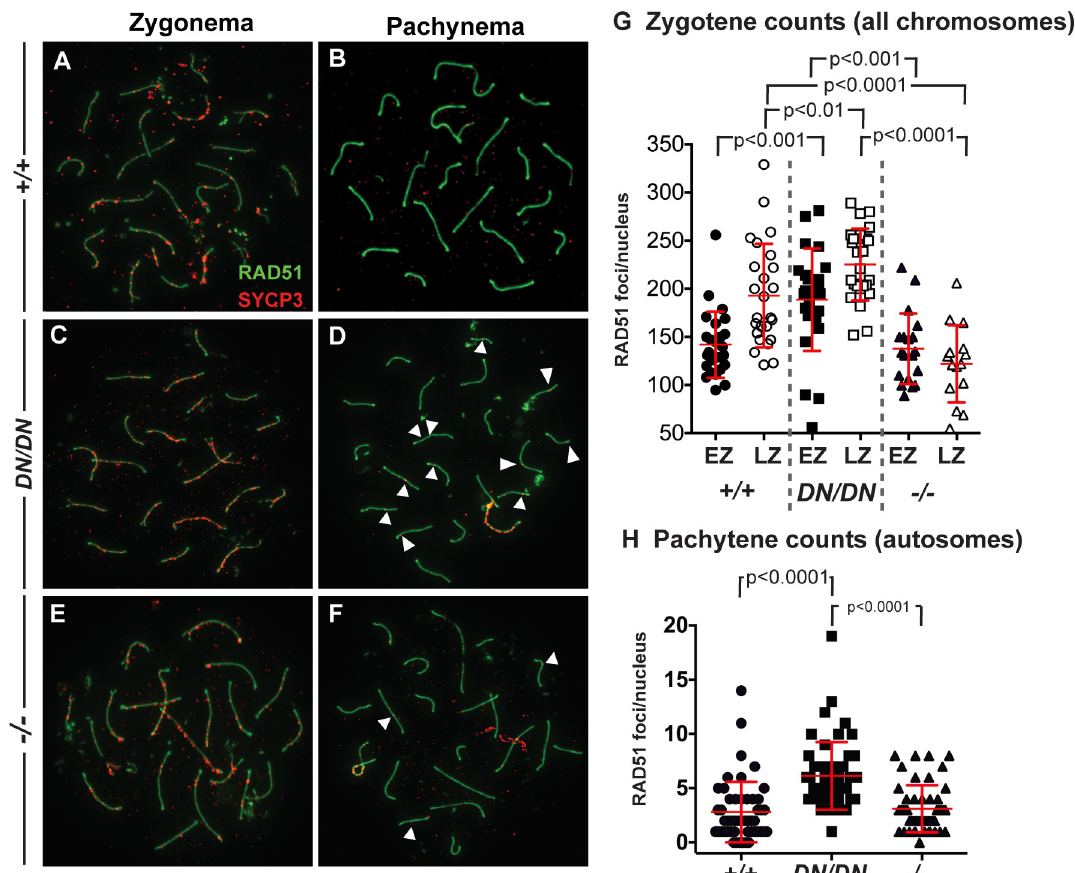
Fig 2. Mlh3 DN/DN spermatocytes show a persistence of RAD51 foci in pachynema. The localization of RAD51 (green) on synaptonemal complex protein SYCP3 (red) is observed in (A, B) WT and (C, D) Mlh3 DN/DN male spermatocytes in zygonema and pachynema. (A, C, E, G) In early zygonema, WT cells show high numbers of RAD51 associated with the chromosome cores while Mlh3 DN/DN exhibit even higher RAD51 foci (WT mean ± standard deviation = 142.1 ± 34.5 foci, Mlh3 DN/DN mean ± s.d. = 188.8 ± 53.3 foci; p values indicated on graph, by unpaired t-test with Welch’s correction, and using Bonferroni’s adjustment for multiple comparison). In late zygonema, Mlh3 DN/DN spermatocytes continue to have higher RAD51 foci than WT (WT mean ± s.d. = 193.0 ± 53.7 foci, Mlh3 DN/DN mean ± s.d. = 225.3 ± 37.3 foci; p values indicated on graph, by unpaired t-test with Welch’s correction, and using Bonferroni’s adjustment for multiple comparison). Mlh3 -/- late zygotene cells show significantly fewer RAD51 focus counts (mean = 122.1 ± 39.9 foci) when compared to WT and Mlh3 DN/DN (p values indicated on graph, by unpaired t-test with Welch’s correction, and using Bonferroni’s adjustment for multiple comparison). In all cases, at least 3 mice were assessed for each genotype and at least 20 cells per mouse (B, D, F, H). In pachynema, WT cells exhibit a dramatic decrease of very few to no RAD51 associated with the autosomes while Mlh3 DN/DN cells show persistent RAD51 (WT mean ± s.d. = 2.8 ± 2.8 foci, Mlh3 DN/DN mean ± s.d. = 6.1 ± 3.1 foci; p < 0.0001, unpaired t-test). Mlh3 -/- pachytene cells exhibit comparable RAD51 focus counts (mean ± s.d. = 3.1 ± 2.1 foci) when compared to WT (p = 0.55 by unpaired t-test), but significantly fewer than Mlh3 DN/DN spermatocytes (p < 0.0001 by unpaired t- test). Note that sex chromosome-associated RAD51 staining was excluded from counts at pachynema. For all chromosome imaging and foci counts, at least three mice of each genotype were observed for each staining